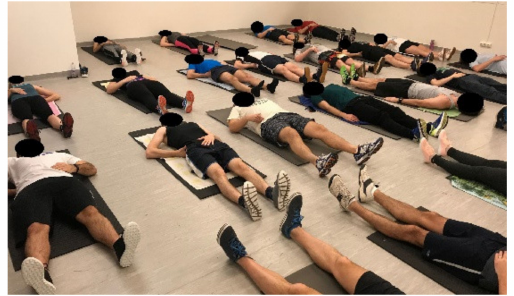
Figure 3. Segmental